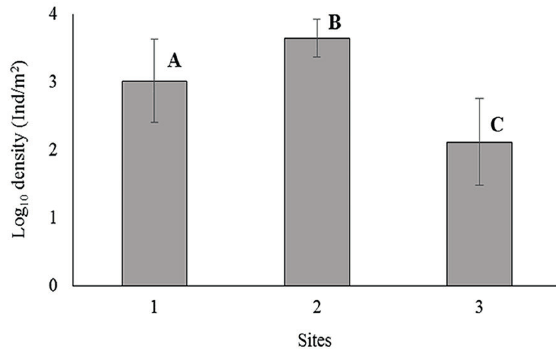
Figure 3 - Total mean population density (ind/m 2 ) of H. pampeana at each study site (lines indicate standard deviation). Values with different letters differ statistically (p<0.05).